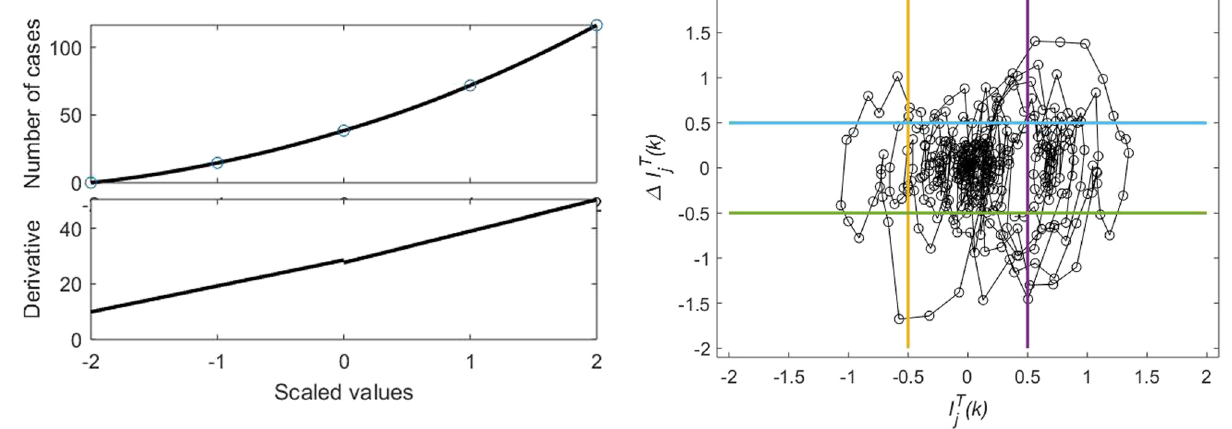
Figure 8: Temporal episodes for the new con fi rmed cases in